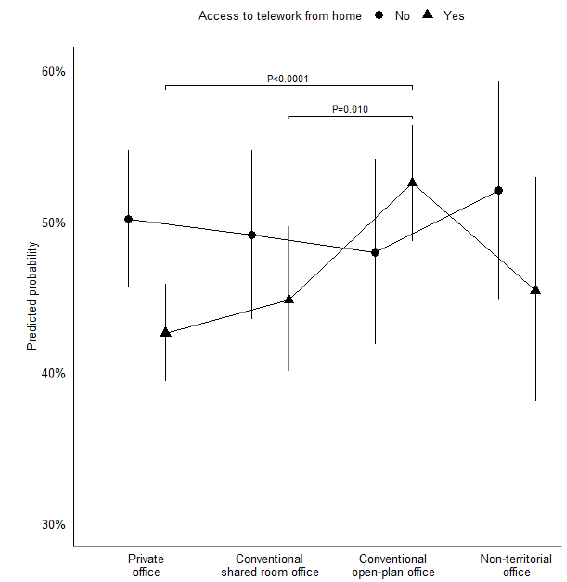
Figure 1. Interaction between office design and access to telework from home. Predicted probabilities and 95% confidence intervals. Results are averaged over age, gender, education level, leadership responsibility, and time spent on office work. Only significance tests within each level of the moderator and with P<0.05 are